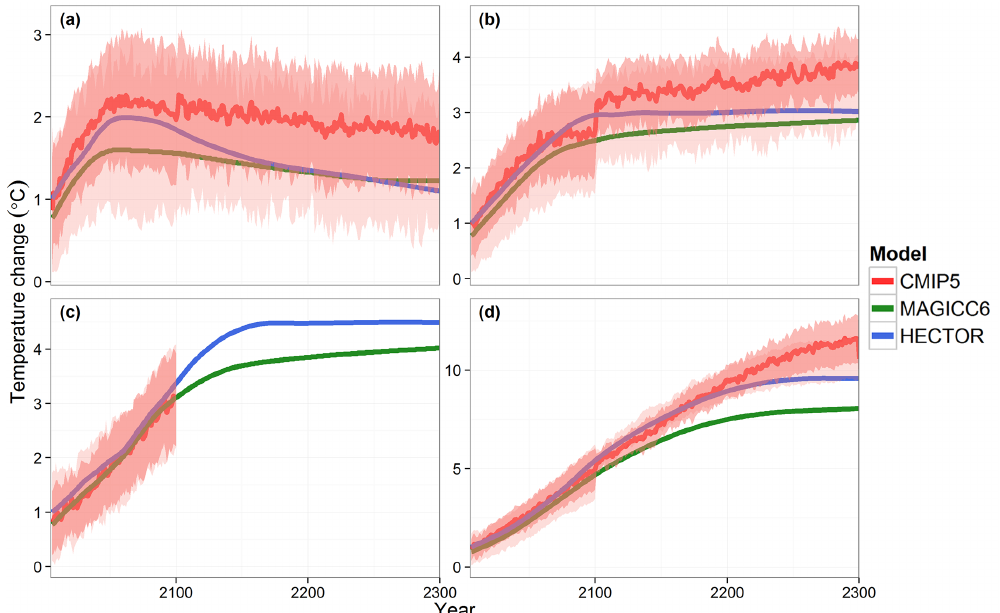
Figure 8. Global temperature anomaly relative to 1850 for (a) RCP 2.6 (b) RCP 4.5 (c) RCP 6.0 and (d) RCP 8.5, comparing Hector (blue), MAGICC6 (green), and CMIP5 median, standard deviation and model range (pink). The CMIP5 models under RCP 6.0 used in this study do not extend to 2300. Note the change in scales between the four panels. Number of CMIP5 models in (a) n = 7 (2006–2100) and n = 5 (2101–2300), (b) n = 9 (2006–2100) and n = 6 (2101–2300), (c) n = 6 (2006–2100), (d) n = 9 (2006–2100) and n = 3 (2101–2300).